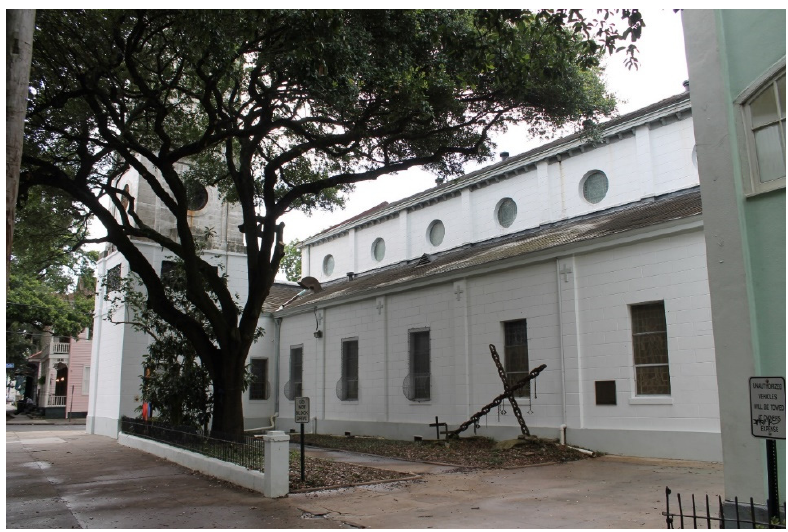
Figure 5. Tomb of the Unknown Slave at north elevation of Saint Augustine Catholic Church. Image by the author. June 2017.